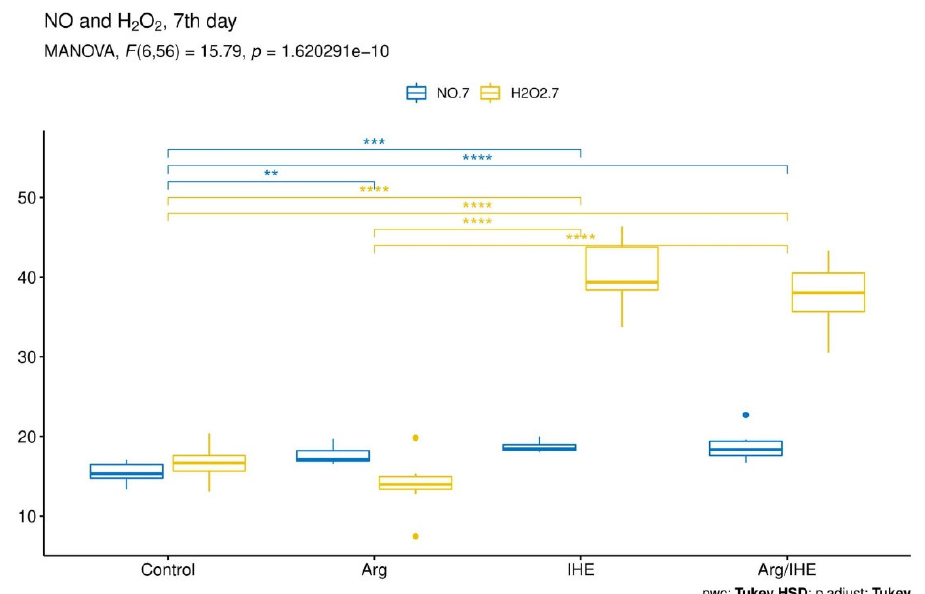
Figure 3. Visualisation of the MANOVA statistical analysis of changes in nitric oxide (NO) and hydrogen peroxide (H 2 O 2 ) levels on the 7th day of the training camp for the following groups: control, arginine (Arg), hypoxic exposure (IHE) and arginine with hypoxic exposure (Arg / IHE). Results of the Tukey HSD post-hoc comparisons are coded as follows: ** p < 0.01, *** p < 0.001, **** p < 0.0001. The homogeneity of covariances and multivariate normality assumptions are met.